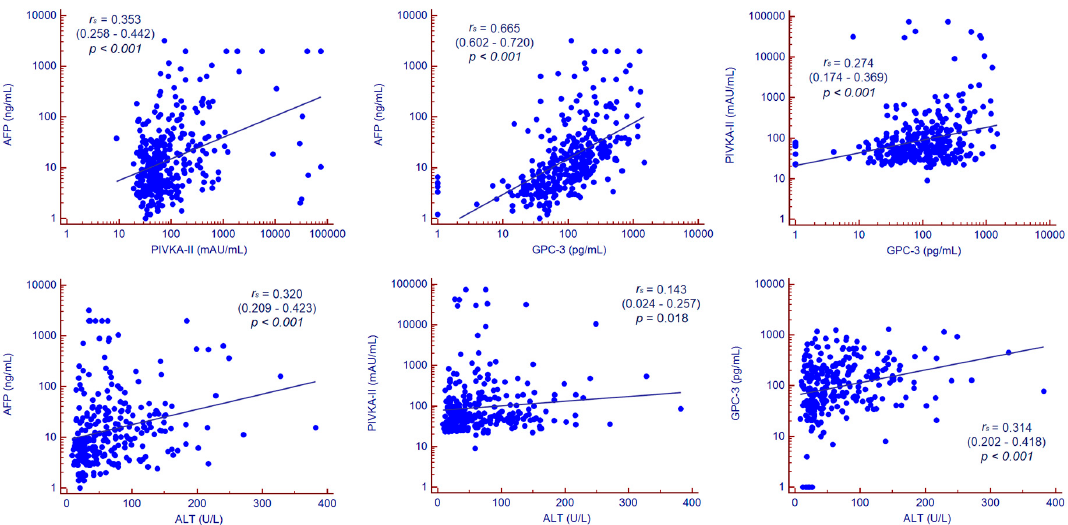
Figure 3. Correlation analysis. Correlation between continuous variables was assessed by Spearman’s rank correlation coefficient. Abbreviations—alpha-fetoprotein (AFP), alanine aminotransferase (ALT), glypican-3 (GPC-3), protein induced by vitamin K absence or antagonist II (PIVKA-II). GPC-3 was positively correlated to ALT ( r s = 0.304, 95% CI 0.194–0.407, p < 0.001), AST ( r s = 0.378, PIVKA-II was positively correlated to ALT ( r s = 0.143, 95% CI 0.027–0.256, p = 0.016), AST ( r s =